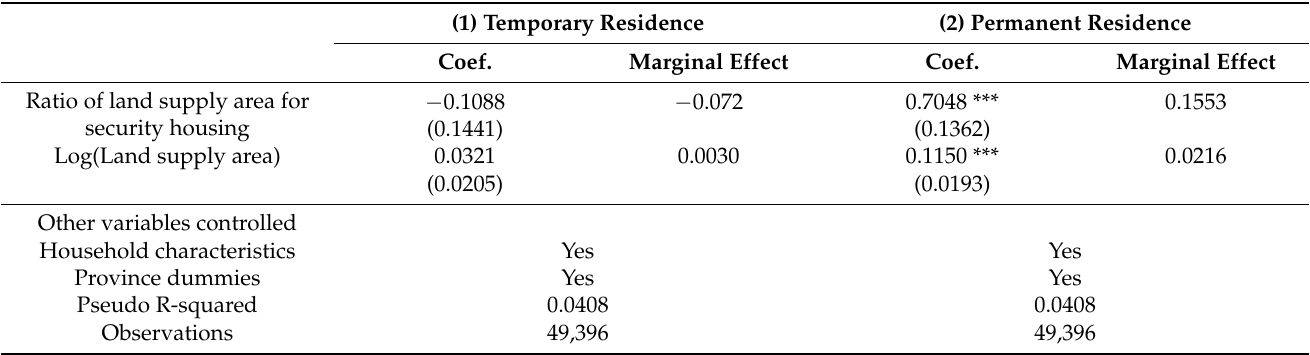
Table 7. Estimated results of housing security and settlement intention (Temporary residence vs.